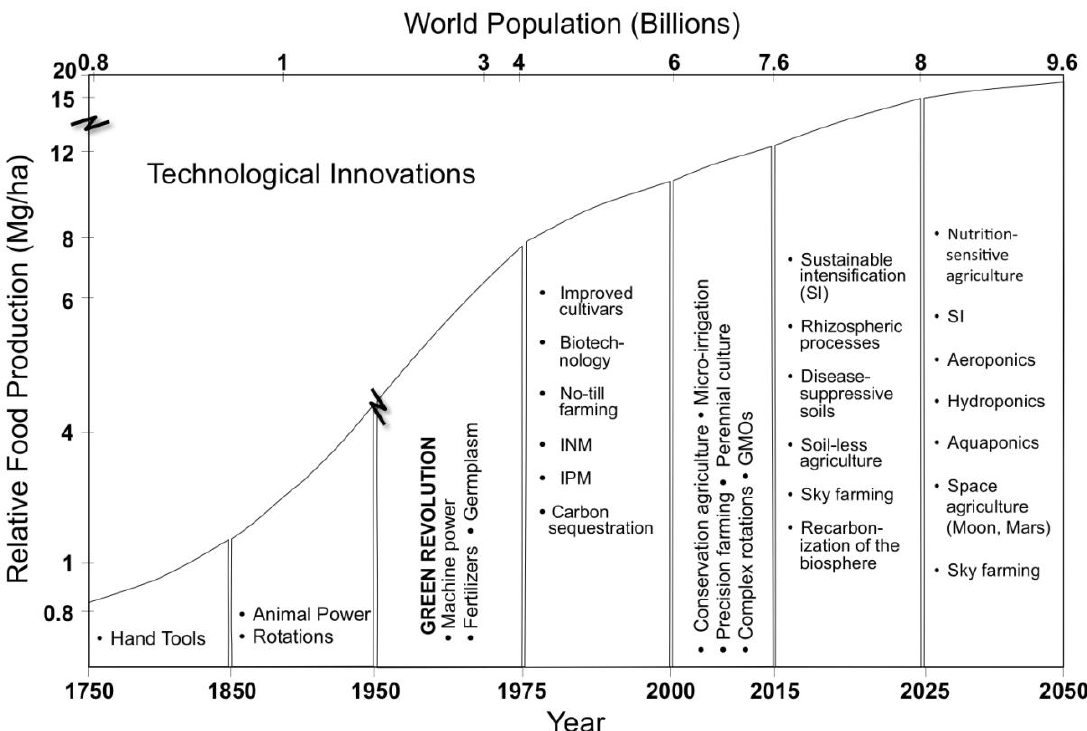
Figure 3. Technological evolution and future innovative and emerging technologies (updated from